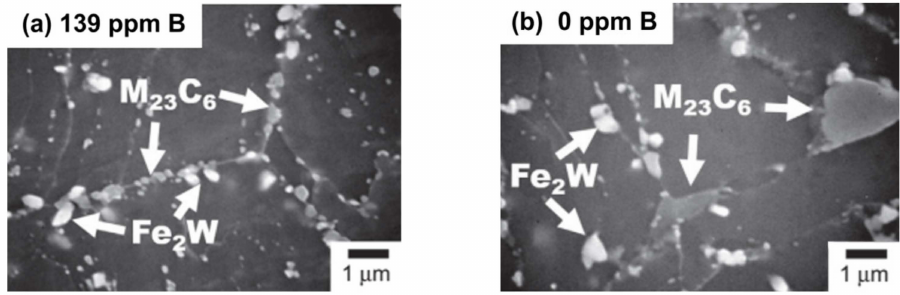
Figure 9. Microstructure of MARBN (9Cr-3W-3Co-VNb) steel with 139 ppm B ( a ) and 0 ppm B ( b ) after aging at 650 ◦ C for 10,300 h. Reprinted with permission from Ref. [7]. Copyright 2017